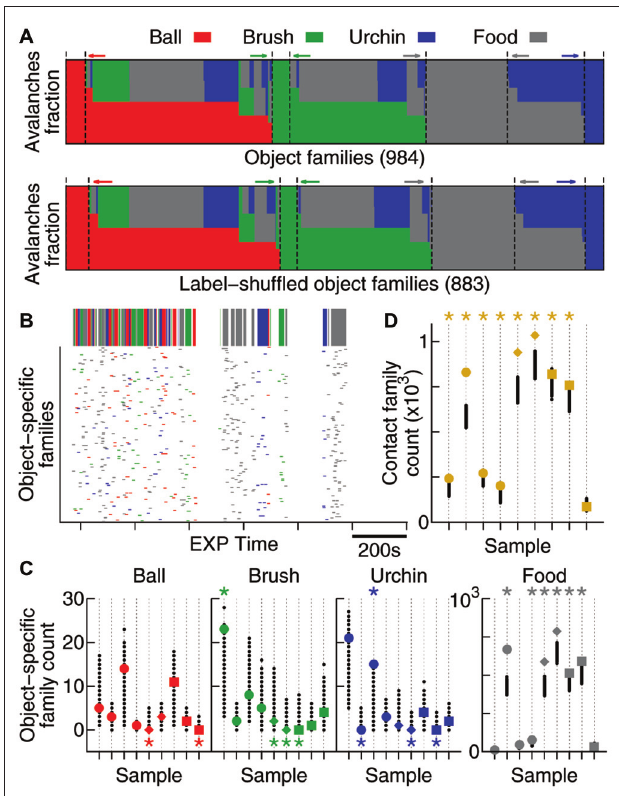
FIGURE 5 | Contact specificity is observed in avalanche patterns. (A) Fraction of avalanches during EXP that occurred while the animal was in contact with each object (coded by colors). Note that the original data (top) and the label-shuffled dataset (bottom) profiles are similar, but the total number of families differs. Dashed lines and colored arrows emphasize families that are specific to a particular object. (B) Time occurrence of avalanches from families which are specific to one object. In detail above, the color-coded bar shows contact windows for each object. (C) Number of object-specific families observed (see “Results” Section). All samples are shown (same order as in previous figures, in colors), together with 1000 label-shuffled sets (in black). Significant cases ( p = 0.025) are marked by asterisks on top (high number) or bottom (low number) of the plot. (D) Same as in (C) , but for contact families or, in other words, families exclusively composed of avalanches that occurred during contact with any